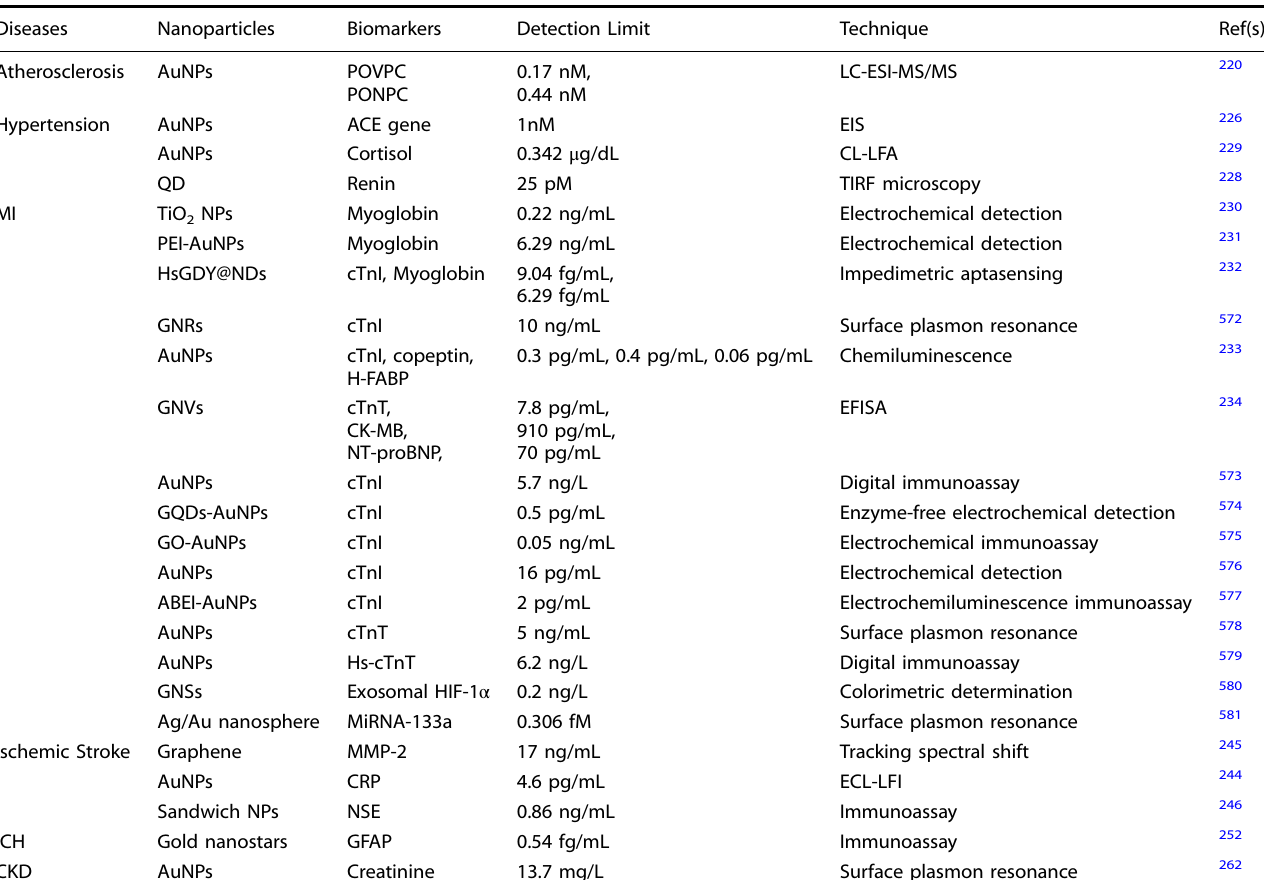
Table 2. Nanoparticles-based biosensors in vascular aging-related diseases Diseases